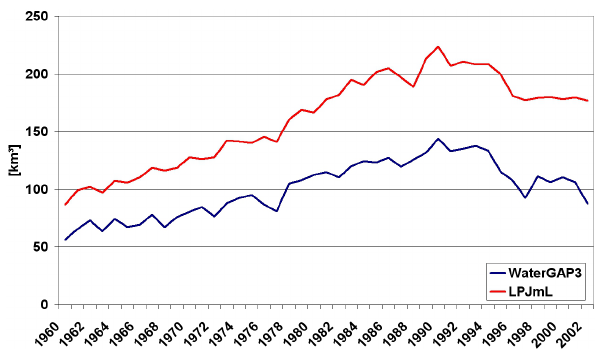
Figure 4: Modelled gross irrigation water requirements for the period 1960 - 2002, aggregated from 42 European countries (see Table 1 for list of countries) Fig. 4. Modelled gross irrigation water requirements for the period 1960–2002, aggregated from 42 European countries (see Table 1 for list of